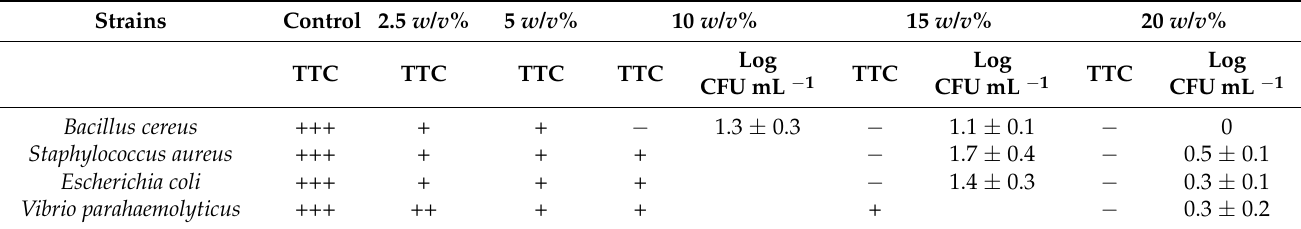
Table 3. Inhibition of n-BGs against bacterial